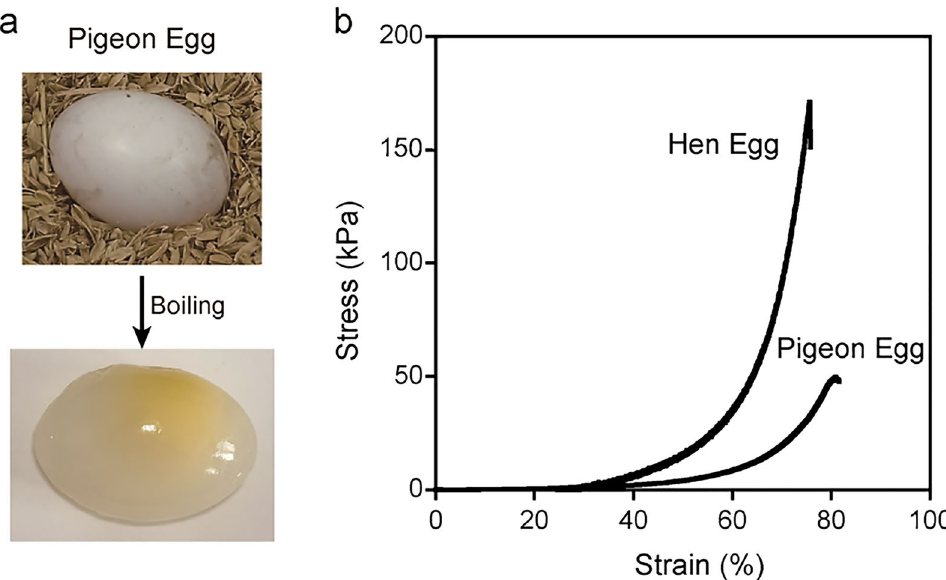
Figure 1. ( a ) Semitransparent appearance of boiled pigeon egg white (PEW); yolk is seen through it. Photos were taken by Xinlian Zhou. ( b ) Compressive stress–strain curves of boiled hen egg white and boiled pigeon egg white, showing the fracture strength of 170 kPa and 50 kPa,